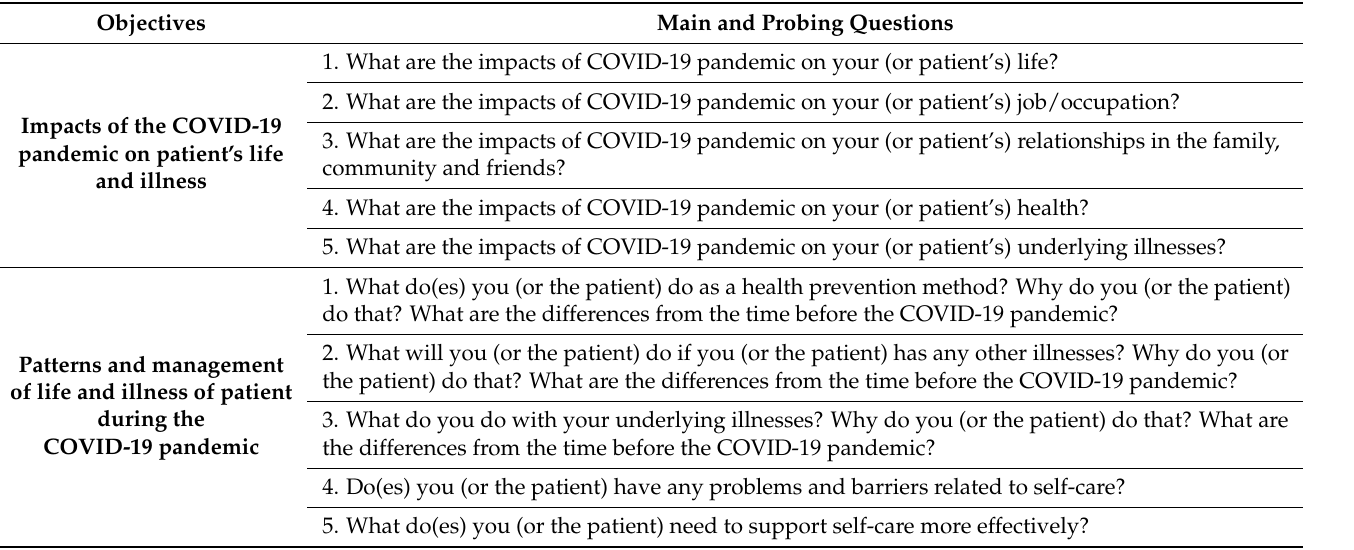
Table 1. Semi-structured interview